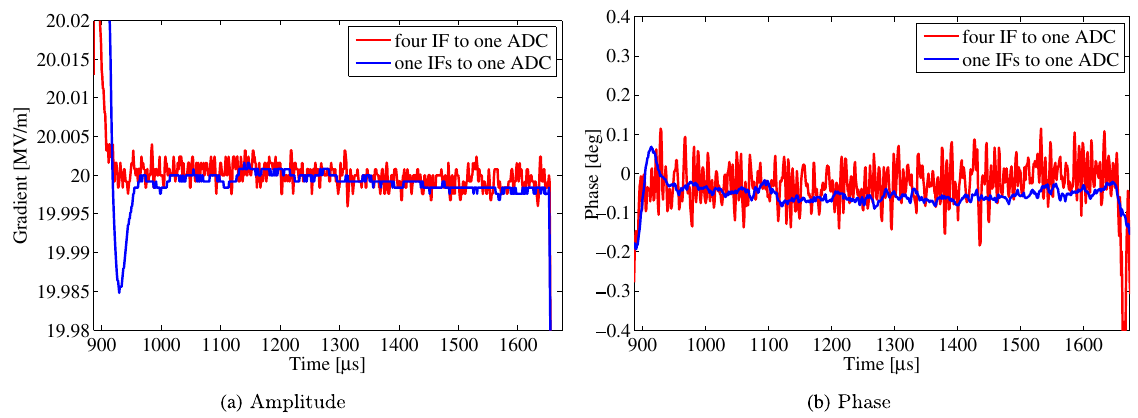
FIG. 10. Flattop of vector sum with four IFs technique. The amplitude and phase stability are 0.006% (rms) and 0.46° (rms), respectively.